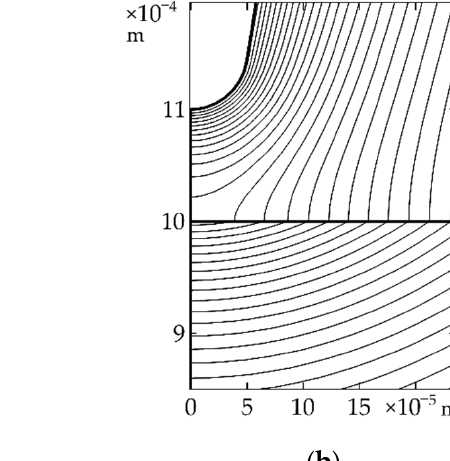
Figure 6. Equipotential lines in the 2nd case under applied 20 kV DC voltage: ( a ) at voltage applica- tion 𝑡 = −200 s ; ( b ) at the steady-state 𝑡 = 0 s .